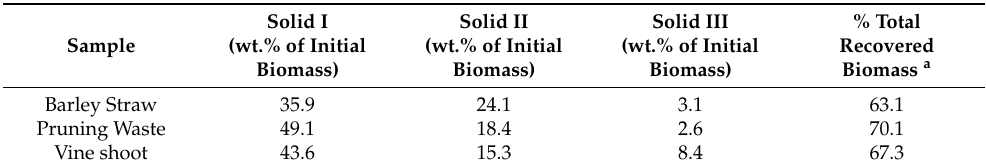
Table 3. Mass balance results of pruning waste after treatment with ISH at 70 °C after 24 h of reaction (solids dried at 105 °C).